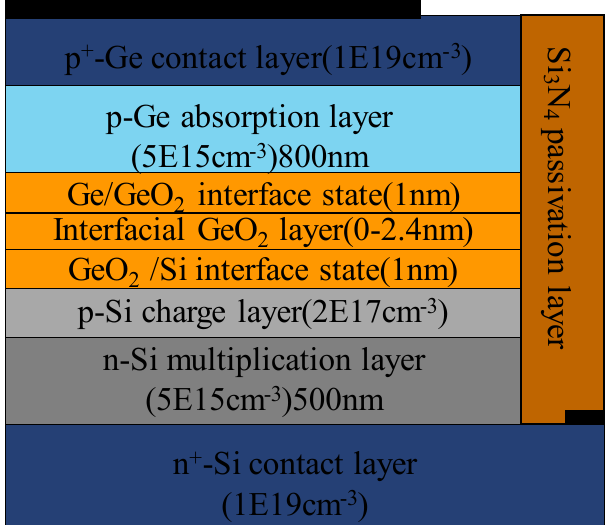
Figure 54. Schematic of wafer-bonded Ge/Si APDs with Ge/GeO 2 interface state and GeO 2 /Si interface state.